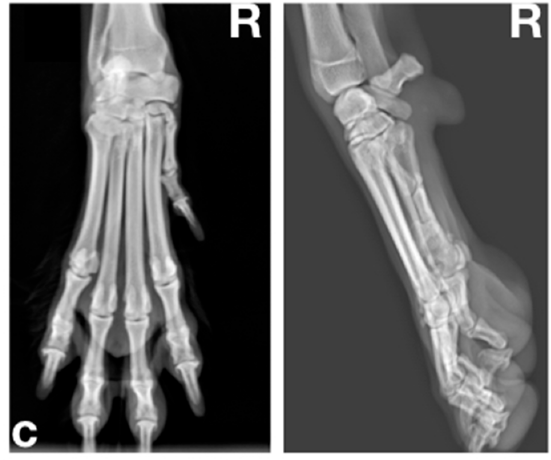
Figure 2. The radiographic assessments of the forepaw of the three patients were within normal limits. ( a ) Case 1 showed no radiographic changes, nor did case 2 ( b ) or case 3 ( c ). Figure 3 shows the US examinations of the forepaws of the three patients compared with the normal ultrasonographic appearance.